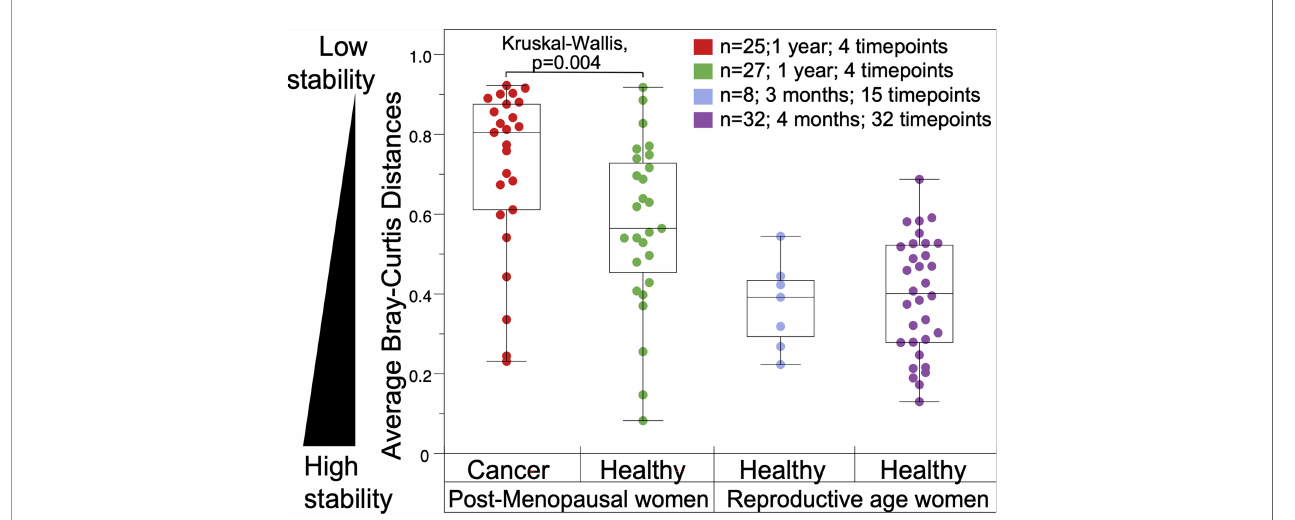
FIGURE 4 | Comparison of vaginal microbiome stability in gynecologic cancer and healthy postmenopausal subjects throughout a year (on the left). (On the right), vaginal microbiomes from reproductive age women from published literature: eight healthy reproductive age women sampled over 3 months (R. J. Hickey et al., 2013); and 32 women sampled over four months (Gajer et al.,